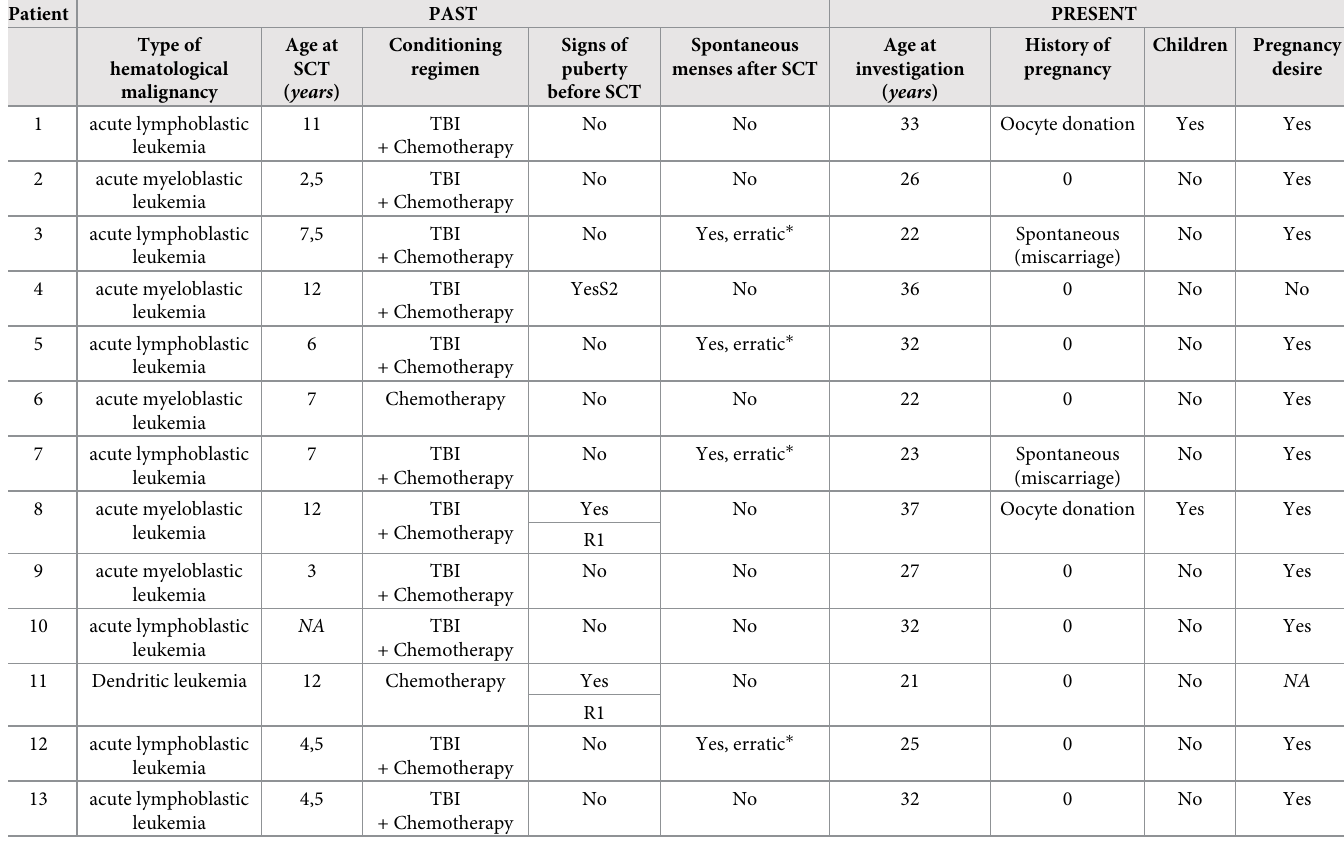
Table 1. Description of